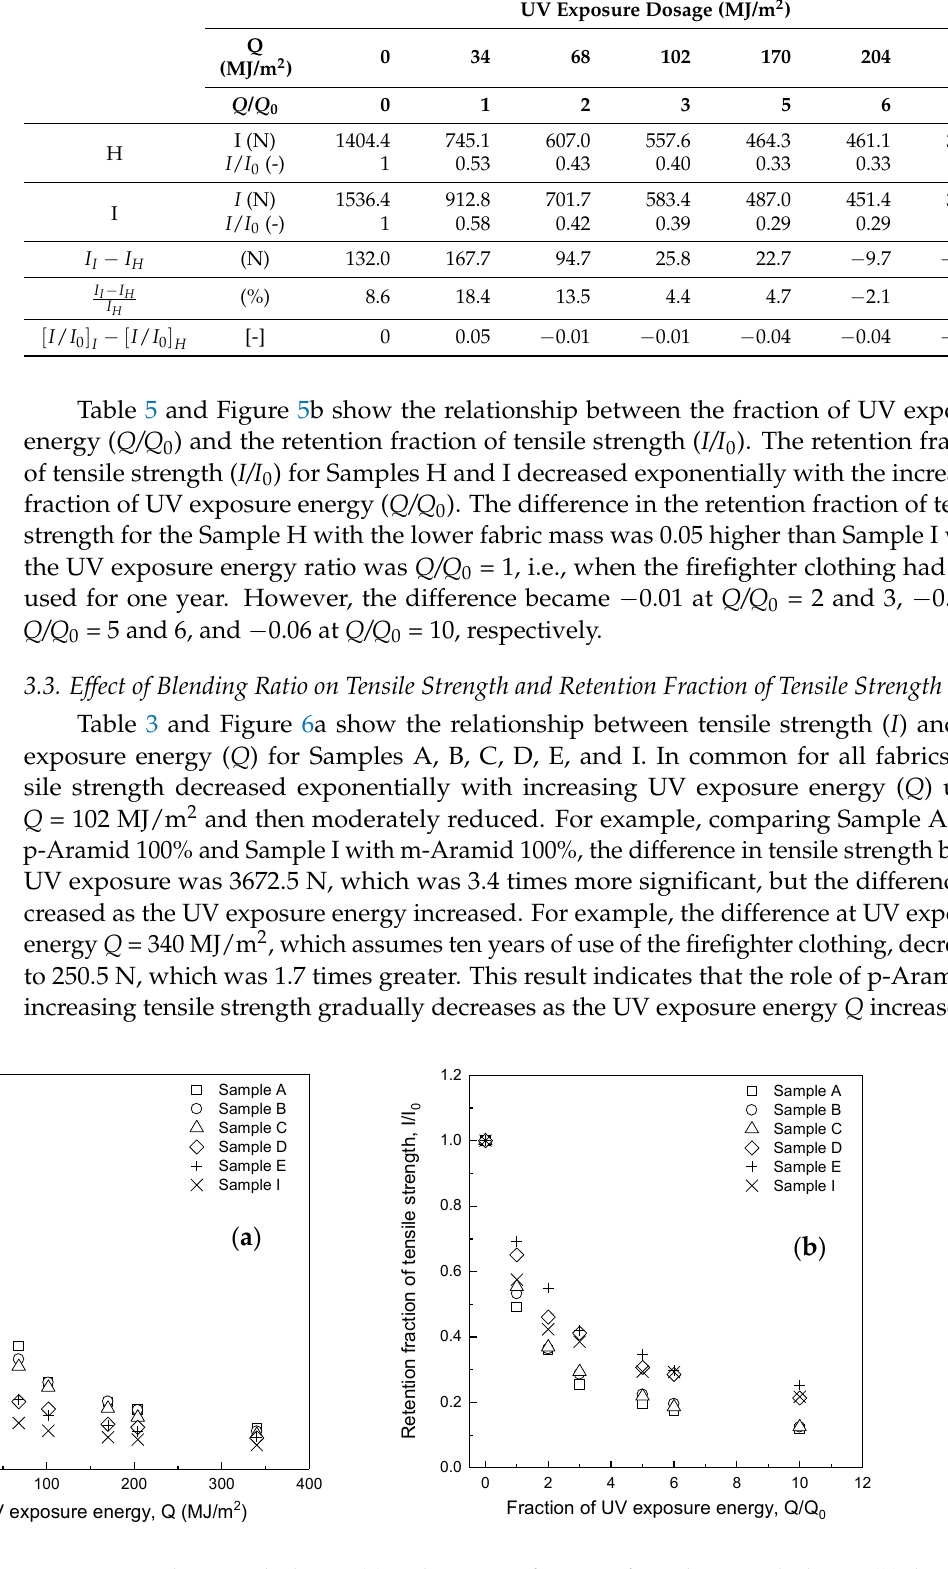
Figure 6. Tensile strength change ( a ) and retention fraction of tensile strength change ( b ) due to the change of p-Aramid/m-Aramid blending